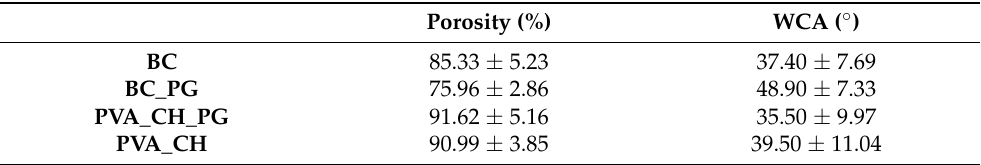
Table 1. Porosity and water contact angle (WCA) values, obtained for each layer produced, with (PVA-CH_PG and BC_PG) and without (PVA-CH and BC) prodigiosin incorporation (data shown as mean ± SD). Porosity